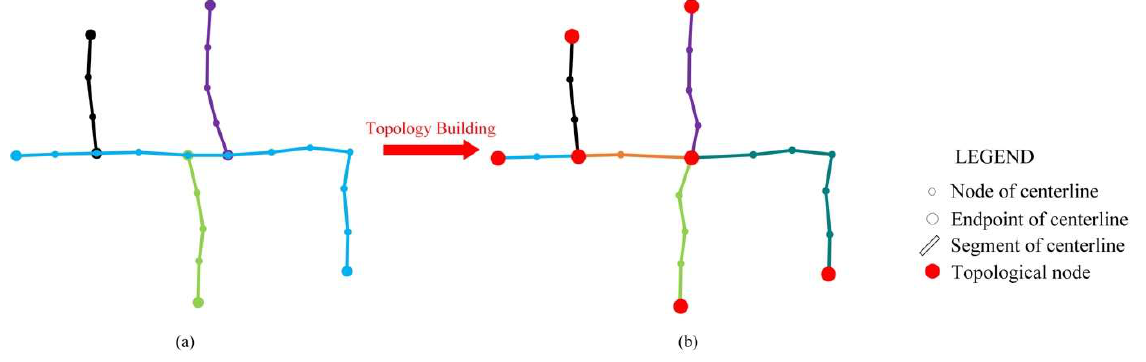
Figure 6. Topological rebuild of the extracted centerlines. The centerlines are shown ( a ) before rebuilding and ( b ) after rebuilding.